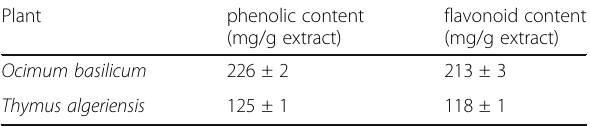
Table 1 Total phenolic and flavonoids contents in the ethanolic extracts of Ocimum basilicum and Thymus algeriensis